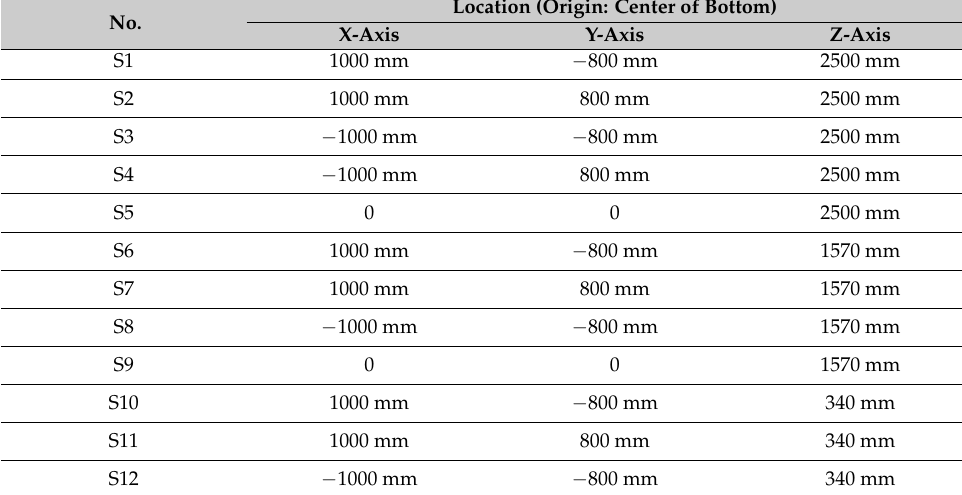
Location (Origin: Center of Bottom)